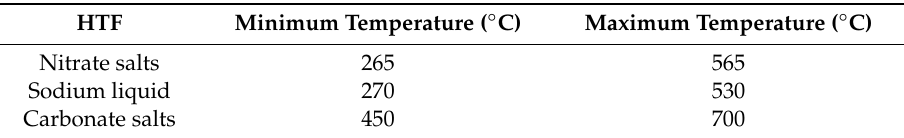
Table 2. Heat transfer fluid (HTF) temperatures.